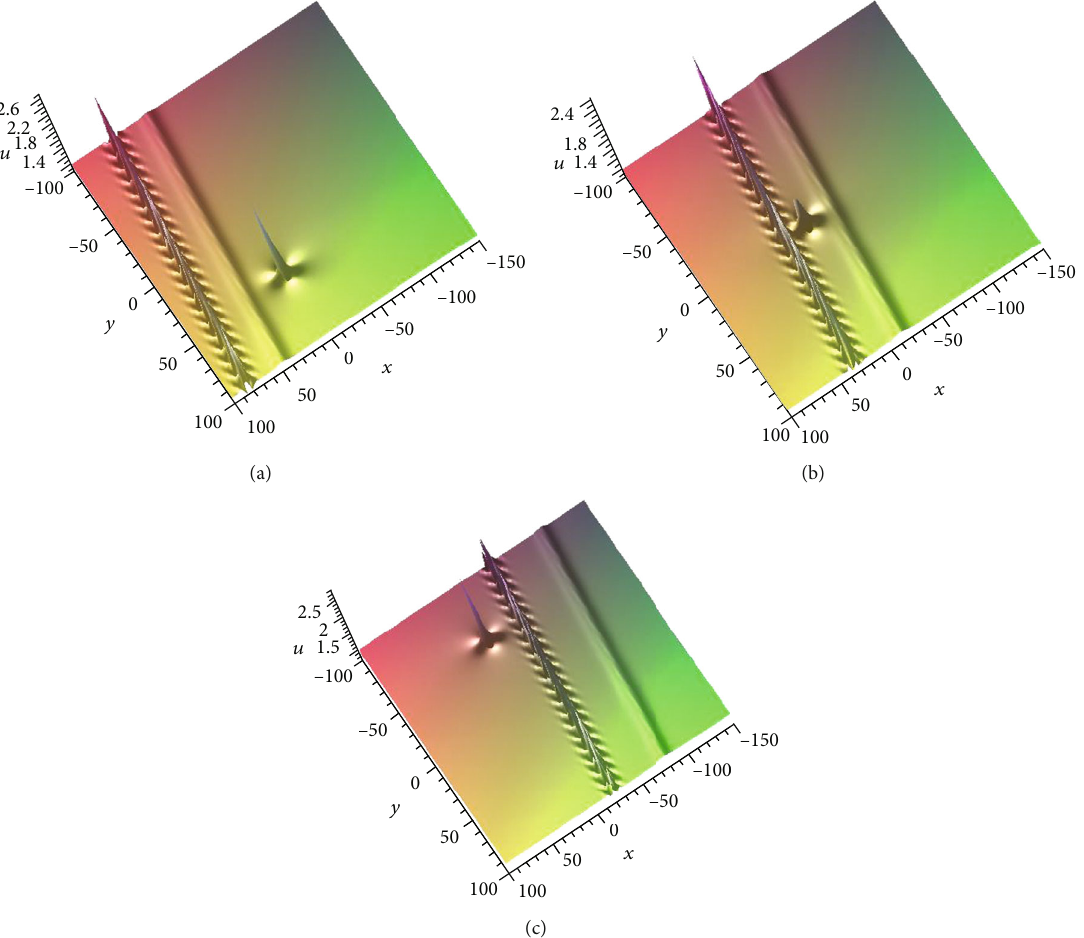
Figure 13: Propagation of hybrid solution composed of a breather-soliton molecule and a lump at di ff erent times: (a) n = − 60 , (b) n = 0 , and (c) n = 65